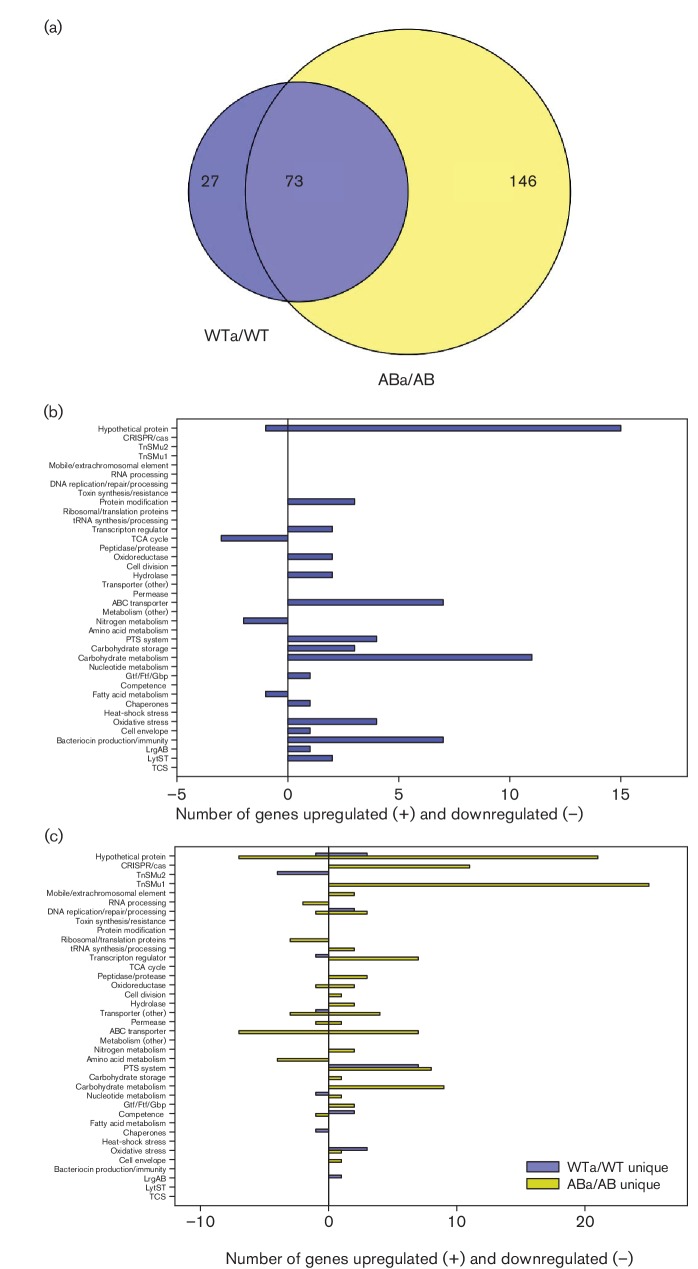
Comparison of wild-type and lrgAB mutant gene expression during aerobic growth. (a) Venn diagrams were used to identify overlapping and unique genes in WTa/WT and ABa/AB DE analyses (≥2.0-fold change and P<0.005). (b) Functional categorization of 73 overlapping genes between WTa/WT and ABa/AB DE analyses (≥2.0-fold change and P<0.005). (c) Functional categorization of 27 and 146 genes unique to WTa/WT (blue bars) and ABa/AB (yellow bars) DE analyses, respectively (≥2.0-fold change and P<0.005). For (b) and (c), functional categories were assigned using genomic functional annotations as well as those found in the DAVID and PATRIC databases. Upregulated genes in each category are found to the right of the y-axis (positive numbers), and downregulated genes are found to the left of the y-axis (negative numbers).